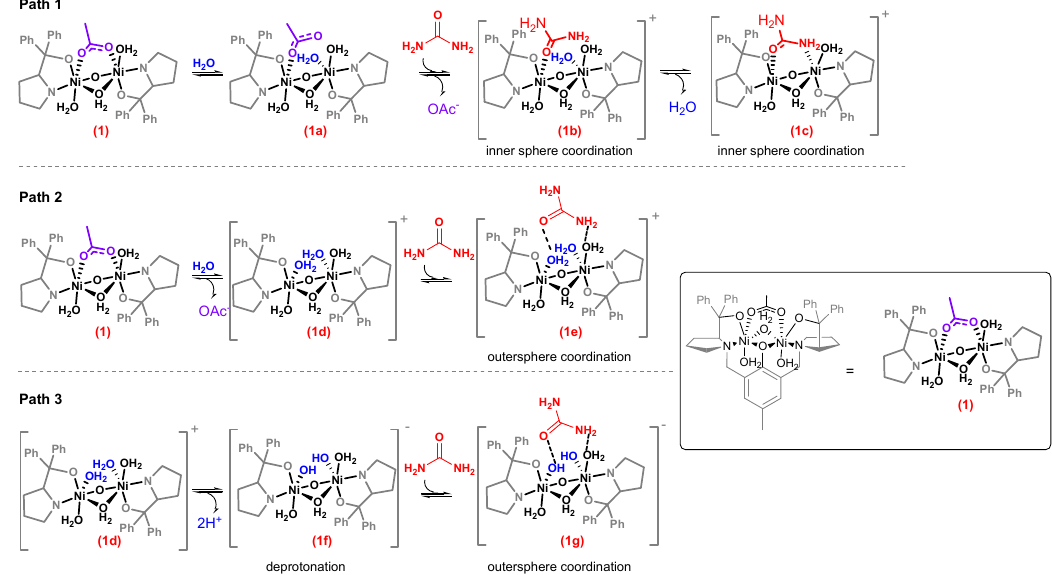
Figure 5. Possible intermediates formed during urea decomposition by (1) complex. Intermediate it 1c is formed upon water and urea coordination to the nickel center via intermediates 1b or 1d, whereas intermediates 1e and 1g are formed with secondary interactions between urea and coordinated water. Subfigure in the box shows the complete molecular representation and its equivalent form involved in catalysis.